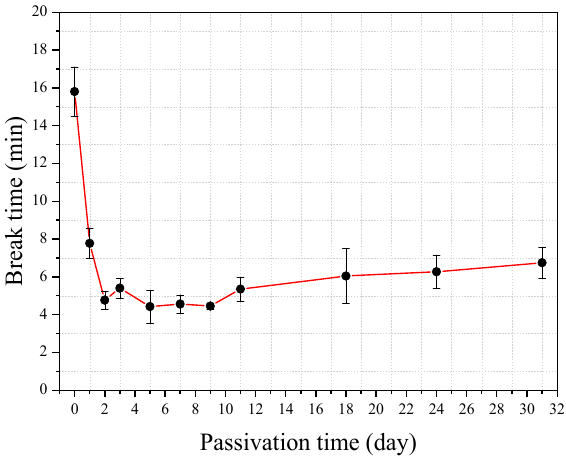
Figure 11. The break time of steel wire with and without passivation treatment (pH = 7, F = 30 N, Cl − = 0.0125 mol/L).